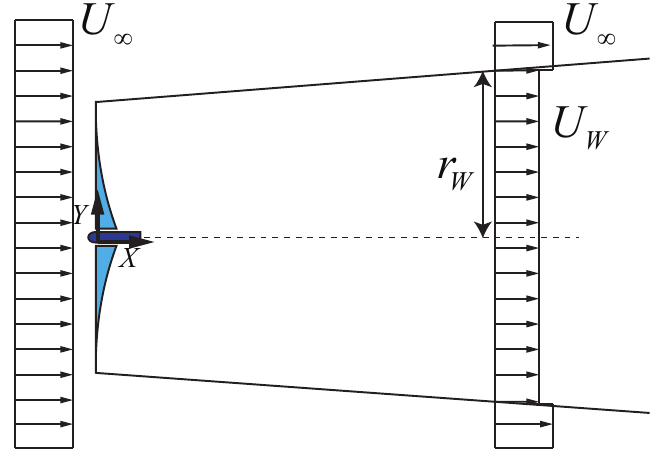
Figure 1. Schematic of the linear wake expansion in the Jensen